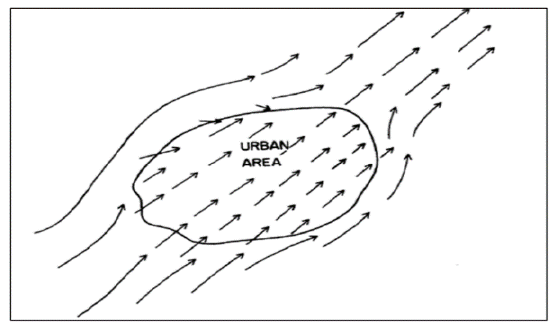
Figure 1. Schematic of low-level airflow over and around a city area due to changes in surface roughness. Notice the size of wind flow vector arrows over the city compared to wind vectors upwind, around, and downwind of cities (Cotton and Pielke [55,56]).